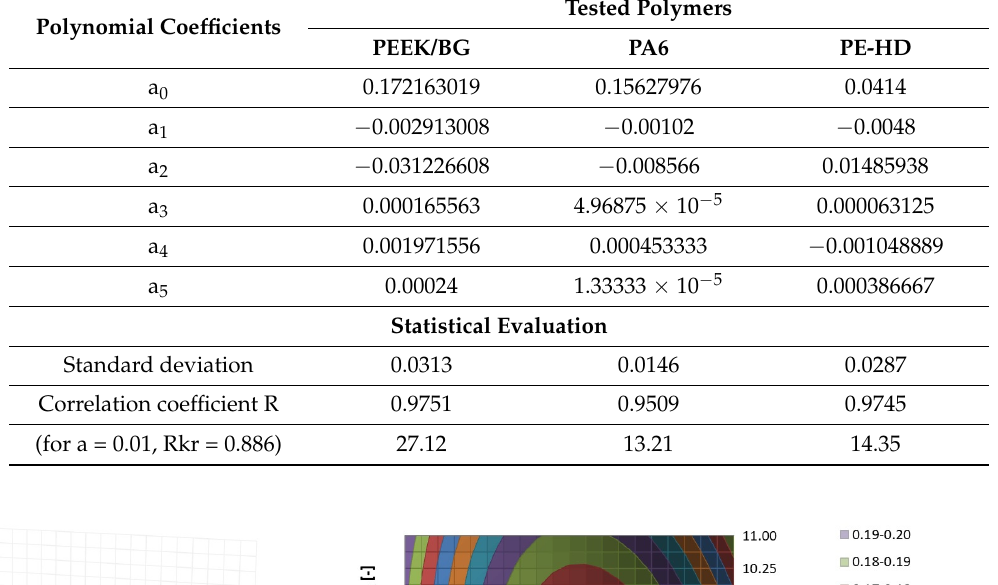
Table 5. Polynomial coefficients and statistical evaluation of regression functions for tested polymers.